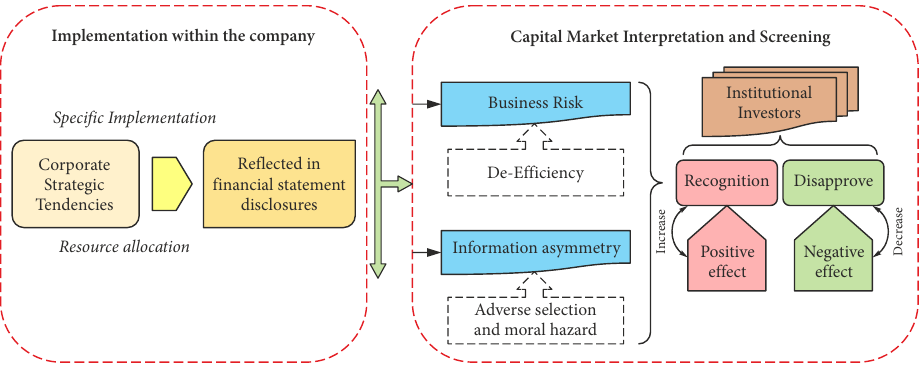
Figure 1. Mechanistic transmission diagram of corporate strategic deviation and institutional investor recognition